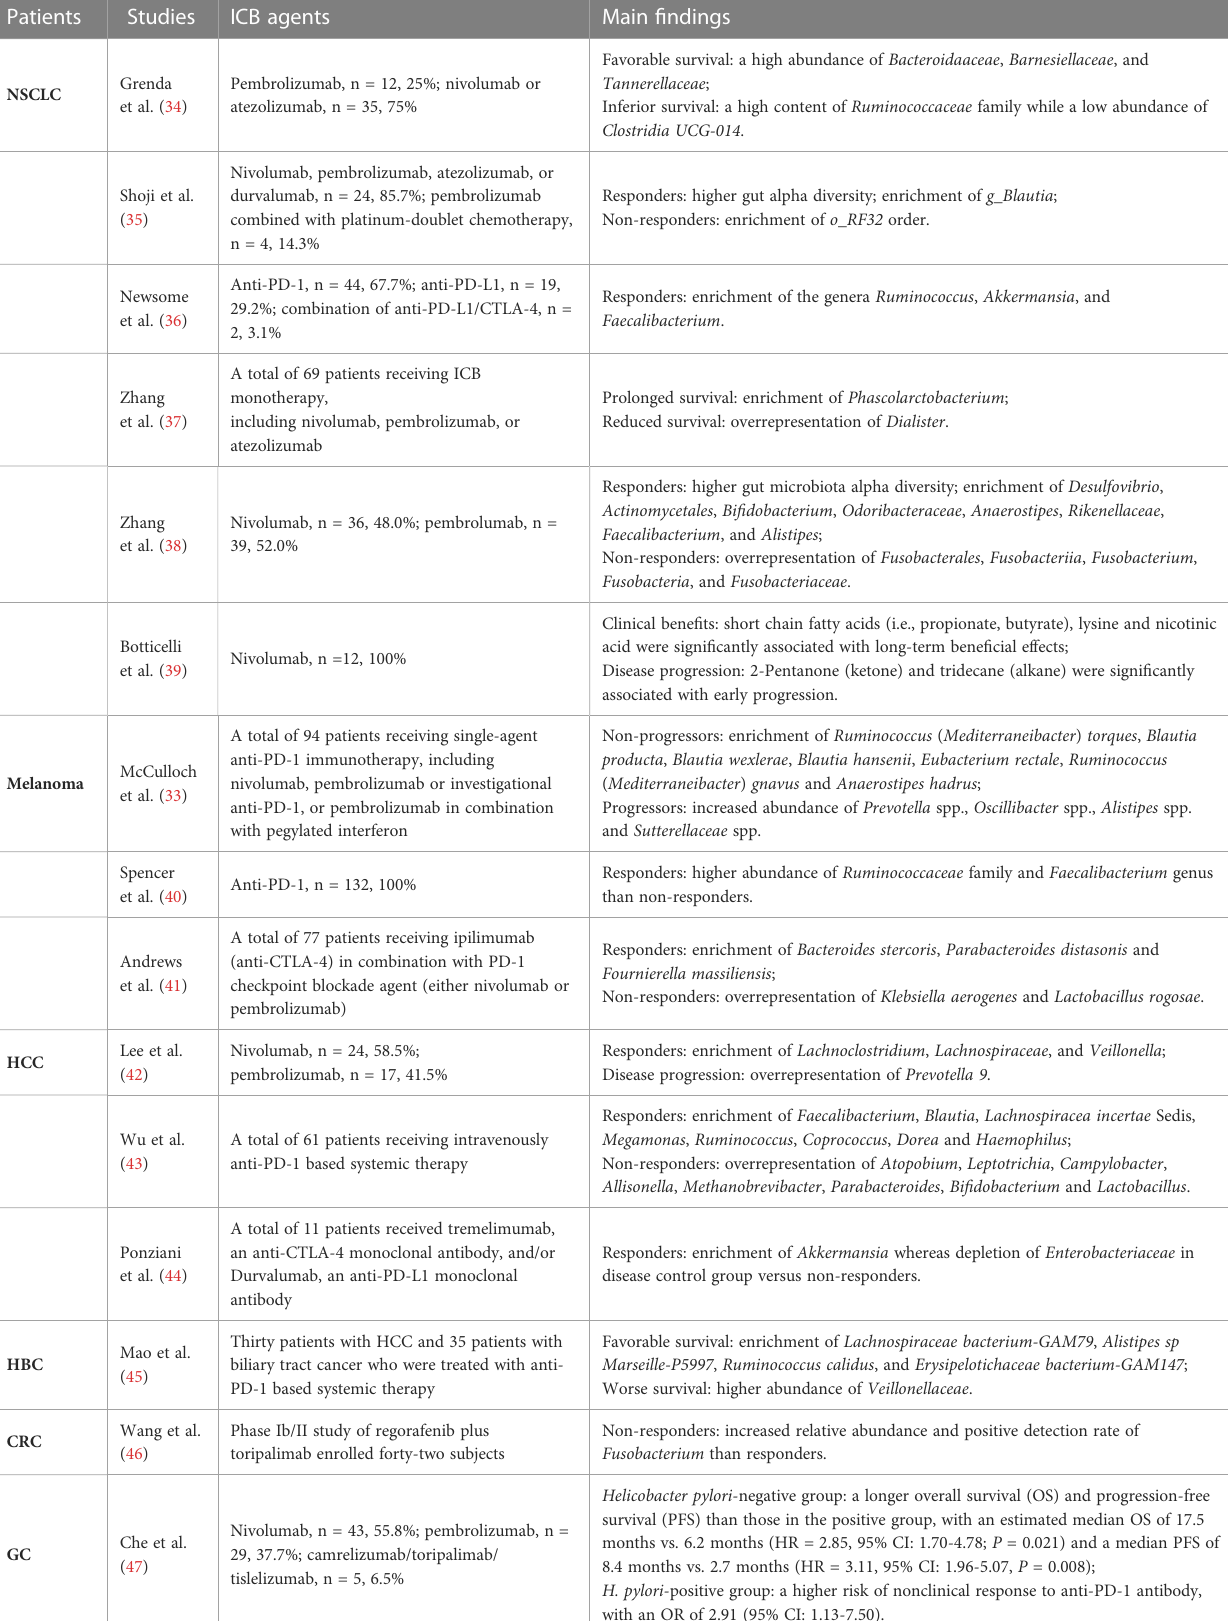
TABLE 1 Representative researches on the interactions between gut microbiota and the outcomes of ICB therapy across cancers in recent three